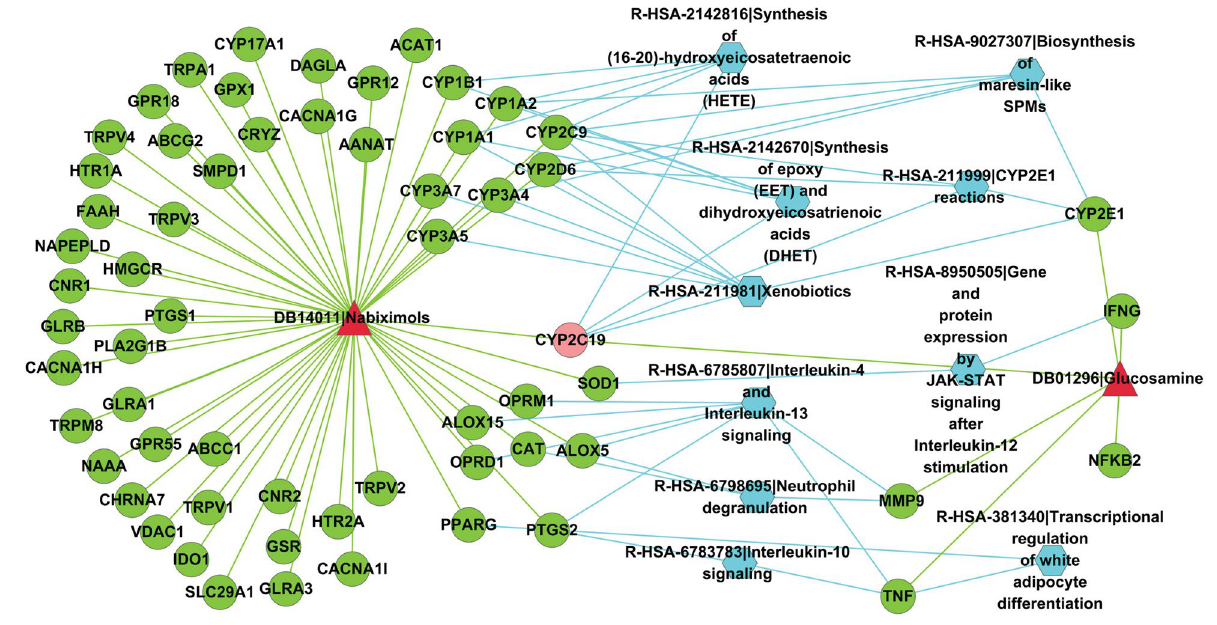
Figure 6. Common target Reactome signaling pathways between DB14011|Nabiximols and DB01296|Glucosamine predicted to interact. Red triangle nodes denote drugs; green circle nodes denote drug target genes; light red circle nodes denote common target genes; and blue hexagon nodes denote Reactome signaling pathways. This drawing is created by Cytoscape version 2.8.2 (https:// cytos cape.